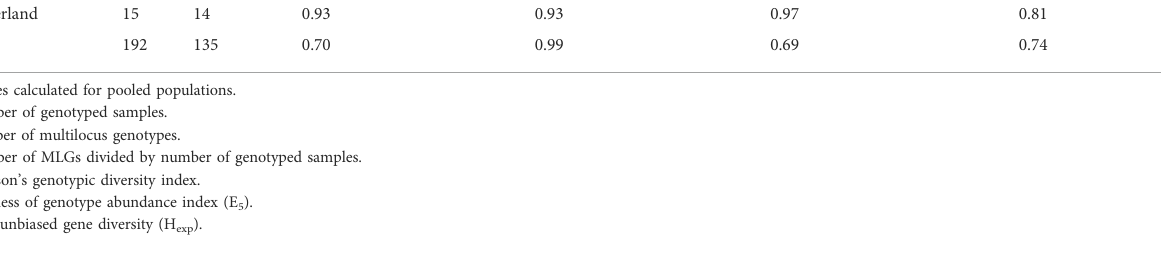
TABLE 3 Analysis of molecular variance (AMOVA) of Puccinia graminis isolates for two individual hierarchies (population and host) based on clone- corrected data. Source of